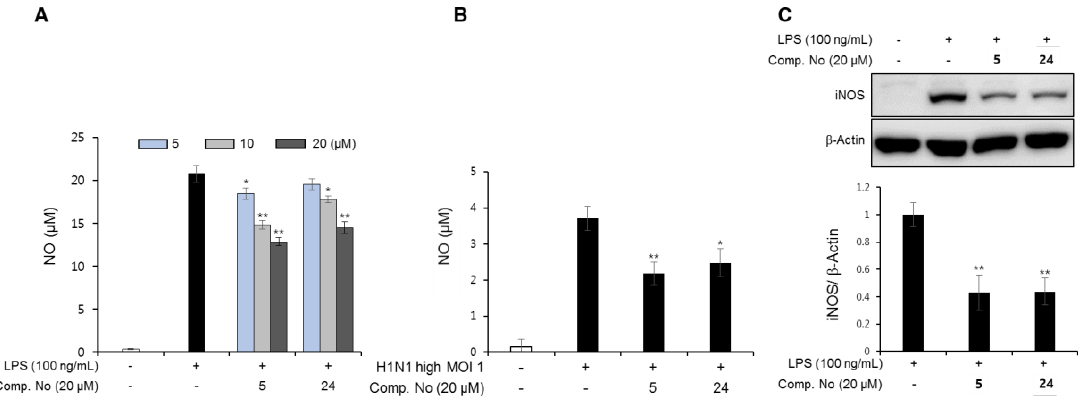
Figure 7. Effects of compounds 5 and 24 on NO production and iNOS expression in RAW 264.7 cells. Treatment of the test compounds at various concentrations to inhibit NO production in RAW 264.7 cells by either ( A ) 100 ng/mL LPS treatment or ( B ) H1N1 A/PR/8/34 viral infection. ( C ) Western blot analysis of iNOS expression in activated RAW 264.7 cells decreased by compounds 5 and 24 at 20 μ M. Data are presented as the mean ± SD ( n = 3), * p < 0.05, ** p < 0.01, compared to the positive control group.